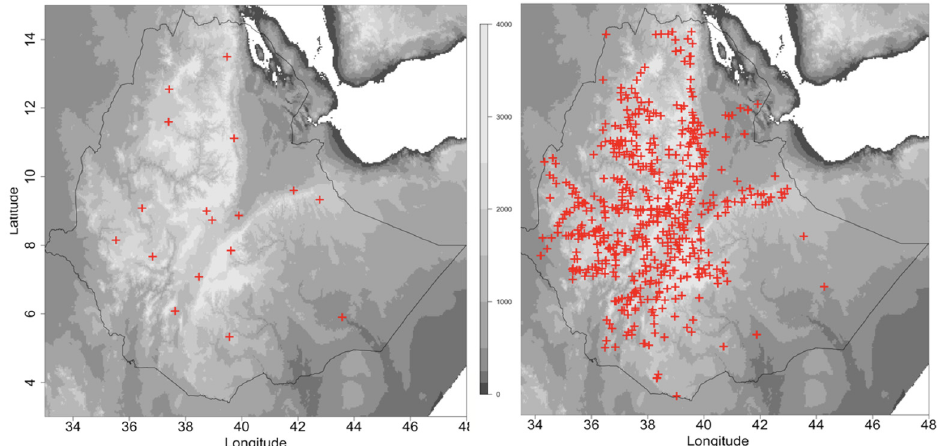
Figure 1. Comparison of GTS (Global Telecommunications System) station distribution ( left ) and stations used in ENACTS (Enhancing National Climate Services) data ( right ) for Ethiopia. Most global satellite rainfall estimates incorporate only data from the GTS